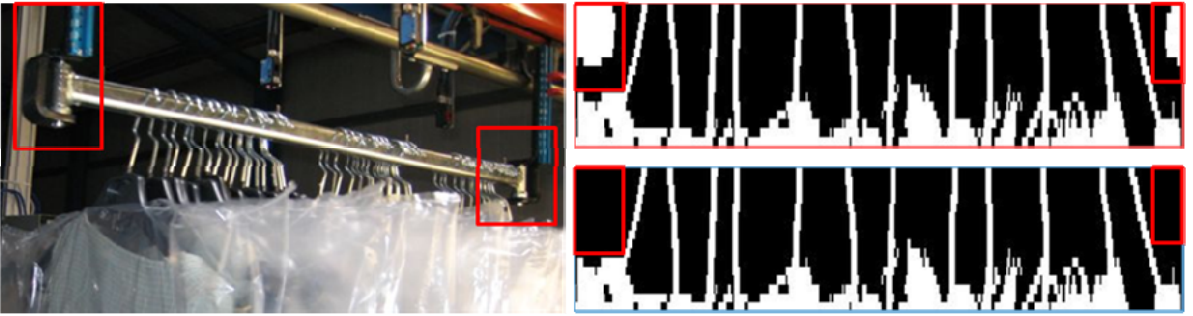
Figure 8. Picture of a trolley. Scanned image with edges. Scanned image without edges.